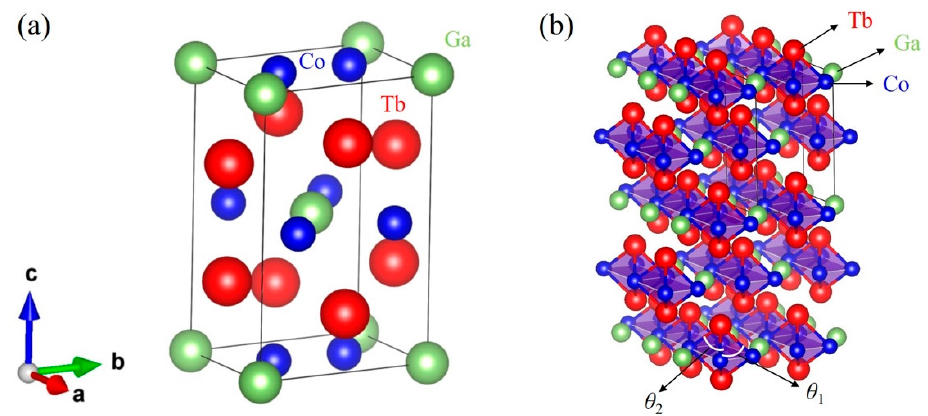
Figure 1. ( a ) Unit cell of Tb 2 Co 2 Ga. ( b ) Crystal structure of Tb 2 Co 2 Ga, emphasizing the polyhedral arrangement. The solid line represents the unit cell. θ 1 and θ 2 are Co–Tb–Co angles in the octahedron formed by two Tb atoms and the nearest neighboring four Co atoms.